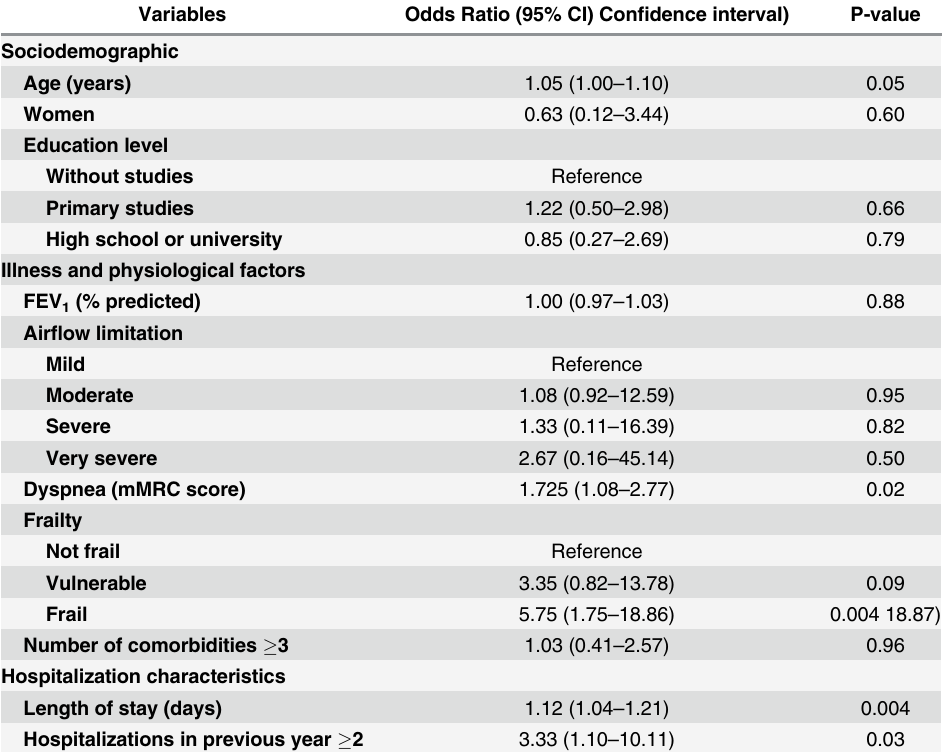
Table 2. Univariable Logistic Regression Predicting Functional Decline at Week 12 after Hospital